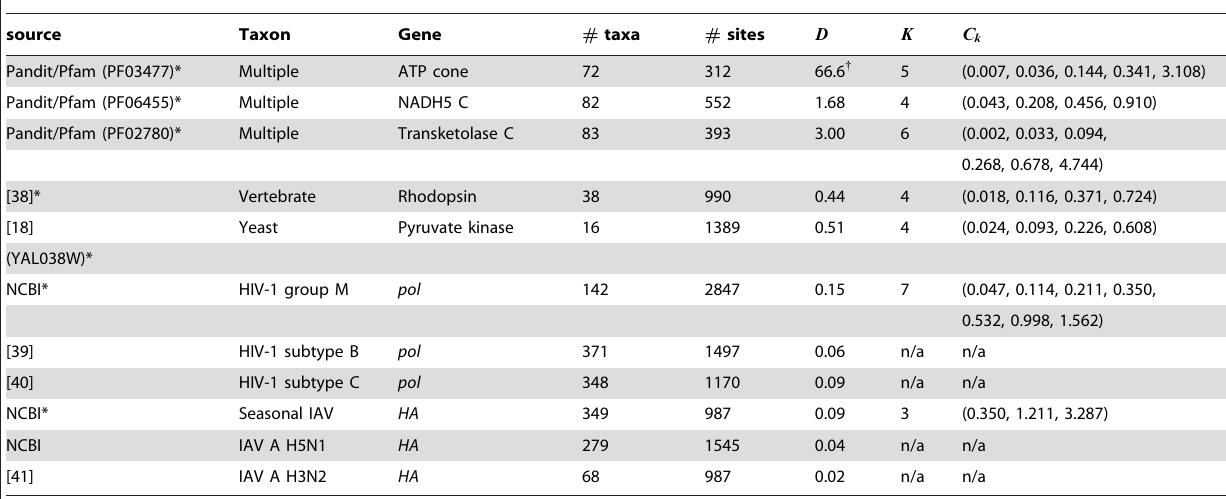
Table 3. Empirical data set